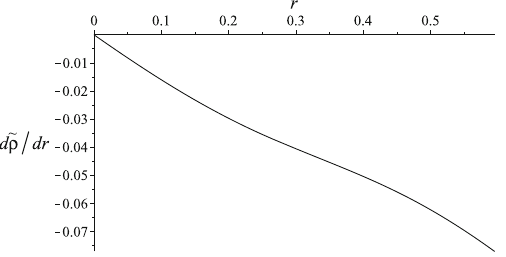
Fig. 10 Gradient of the energy density for the solution obtained with the first algorithm with F (cid:9)= 0 from the isotropic Gold III solution